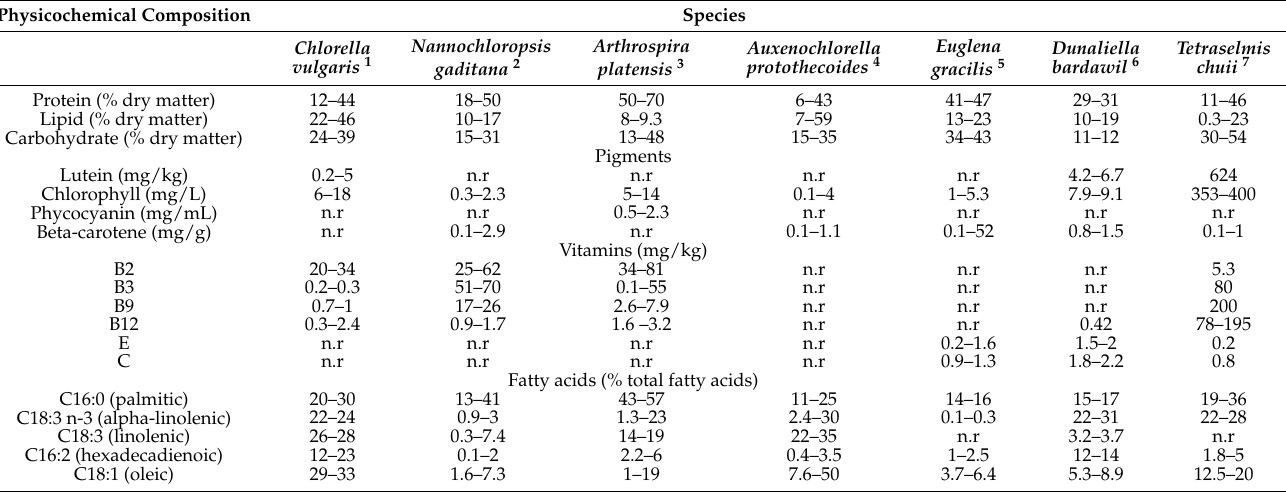
Table 1. Physicochemical composition of the most studied species of